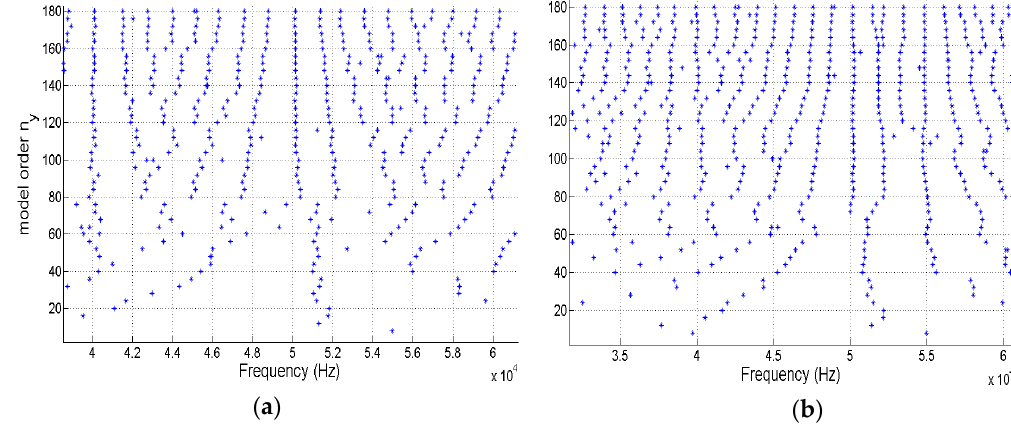
Figure 10. Stabilization plots with ‘*’ indicating poles at each frequency: ( a ) type-C1 and ( b ) type-C2 slabs. For values ny ≥ 80, poles are consistently assigned at the monitored frequencies of interest (around 40 and 50 KHz).